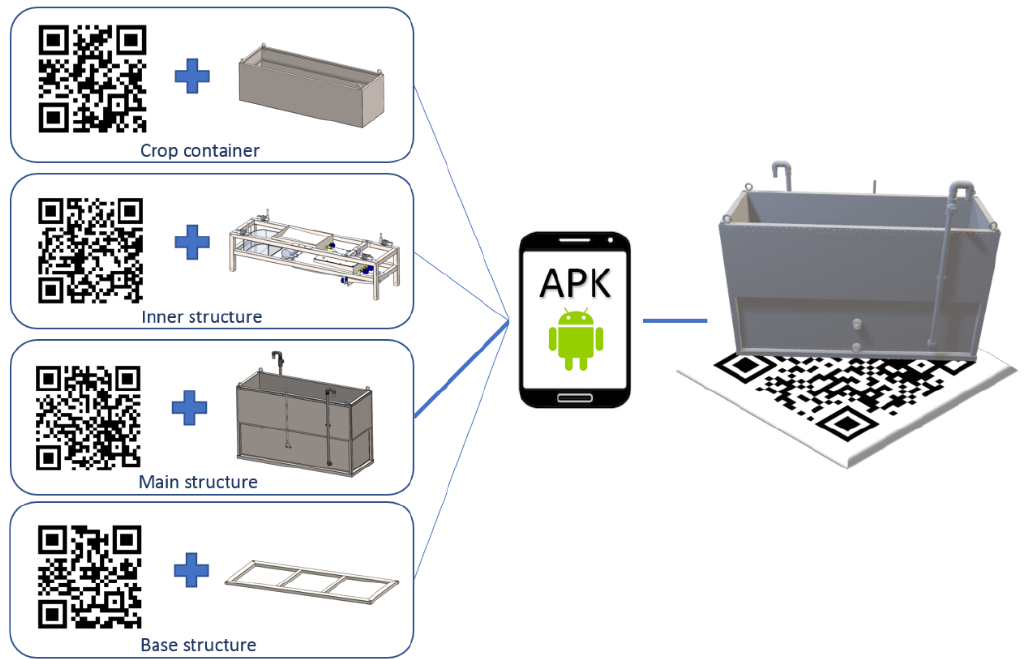
Figure 10. Procedure with proposed ferticontrol equipment.